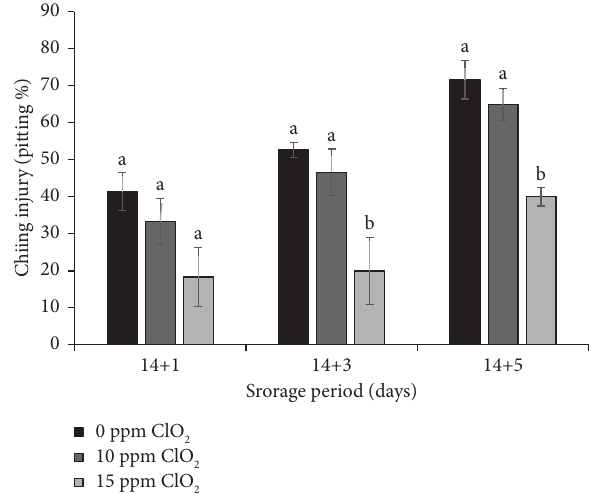
Figure 3: Efect of ClO 2 treatment on chilling injury in tomatoes stored at 4 ° C for 14 days followed by 5 days at 20 ° C. Graphs plotted represent mean values ± standard error (SE) of three replicated measurements. Diferent lowercase letters in the graph indicate statistically signifcant diferences at P < 0 .